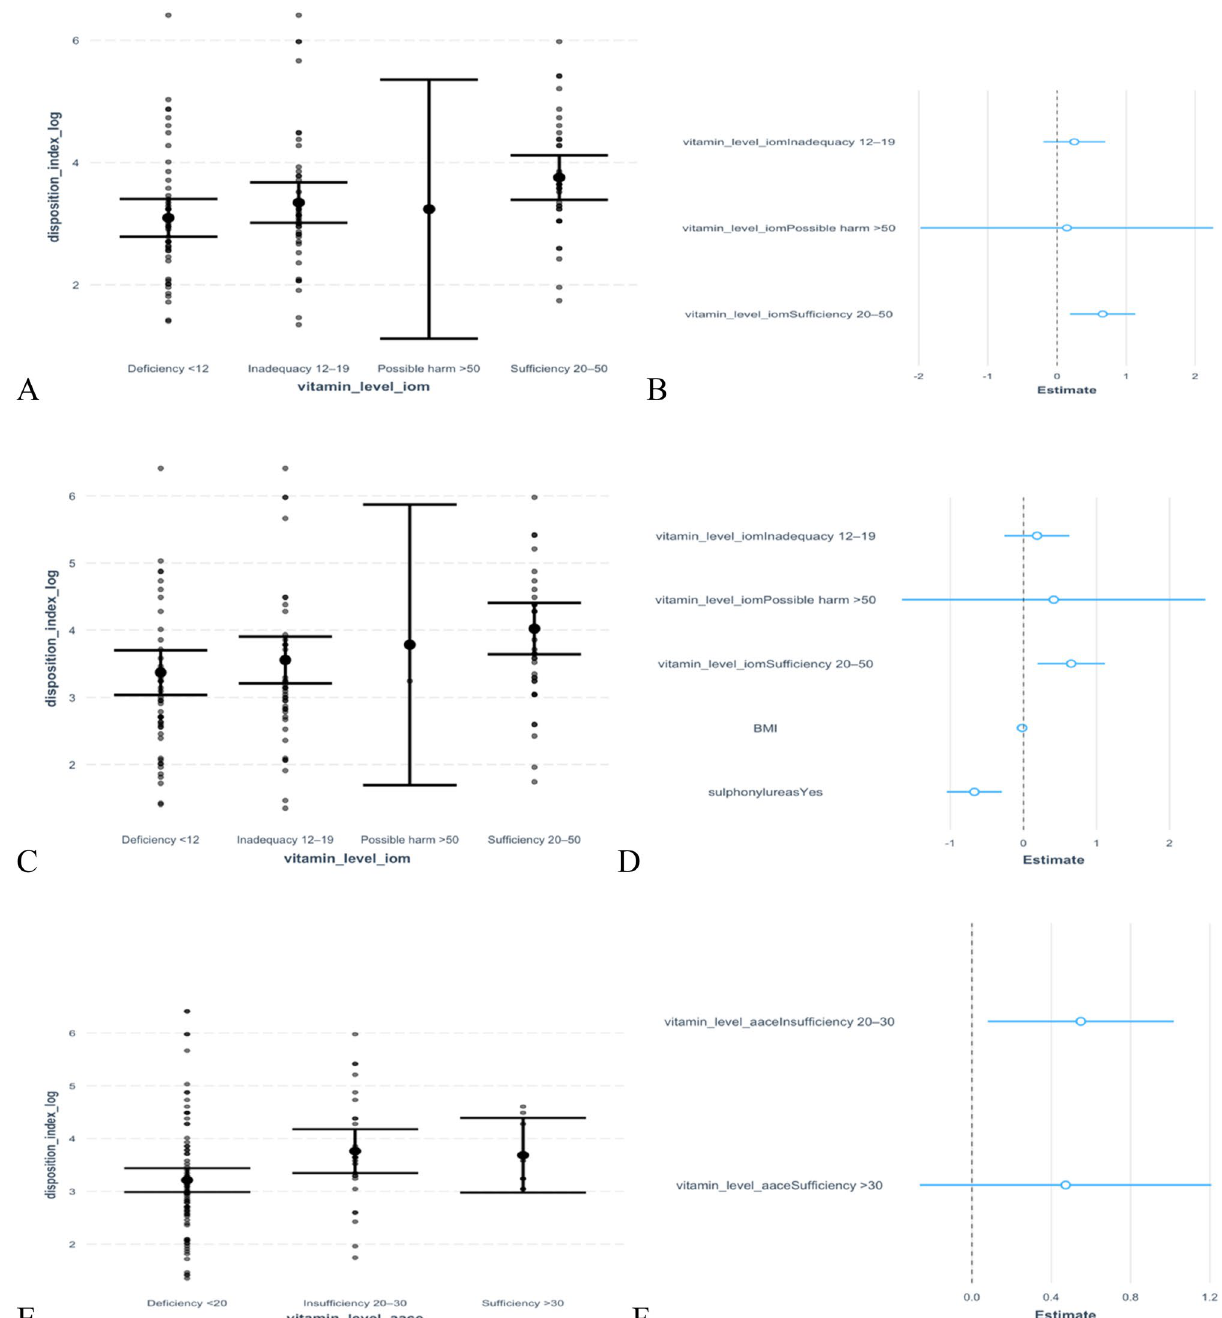
Figure 5. Adjusted and un-adjusted relationship between vitamin D and log of disposition index, with comparison between IOM and AACE Vitamin D thresholds. ( A ) Box plots showing un-adjusted linear regression correlation between Vitamin D levels (categorised according to IOM thresholds) and log of disposition index. ( B ) Forest plot showing un-adjusted linear regression correlation between Vitamin D levels (categorised according to IOM thresholds) and log of disposition index. ( C ) Box plots showing linear regression correlation between Vitamin D levels (categorised according to IOM thresholds) and log of disposition index, adjusted for BMI and sulfonylurea use. ( D ) Forest plot showing linear regression correlation between Vitamin D levels (categorised according to IOM thresholds) and log of disposition index, adjusted for BMI and sulfonylurea use. ( E ) Box plots showing un-adjusted linear regression correlation between Vitamin D levels (categorised according to AACE thresholds) and log of disposition index. ( F ) Forest plot showing un-adjusted linear regression correlation between Vitamin D levels (categorised according to AACE thresholds) and log of disposition index. ( G ) Box plots showing linear regression correlation between Vitamin D levels (categorised according to AACE thresholds) and log of disposition index, adjusted for BMI and sulfonylurea use. ( H ) Forest plot showing linear regression correlation between Vitamin D levels (categorised according to AACE thresholds) and log of disposition index, adjusted for BMI and sulfonylurea use. ( I ) Forest plot comparing linear regression correlation between Vitamin D levels (categorised according to both IOM and AACE thresholds) and log of disposition index, after adjustment for BMI and sulfonylurea